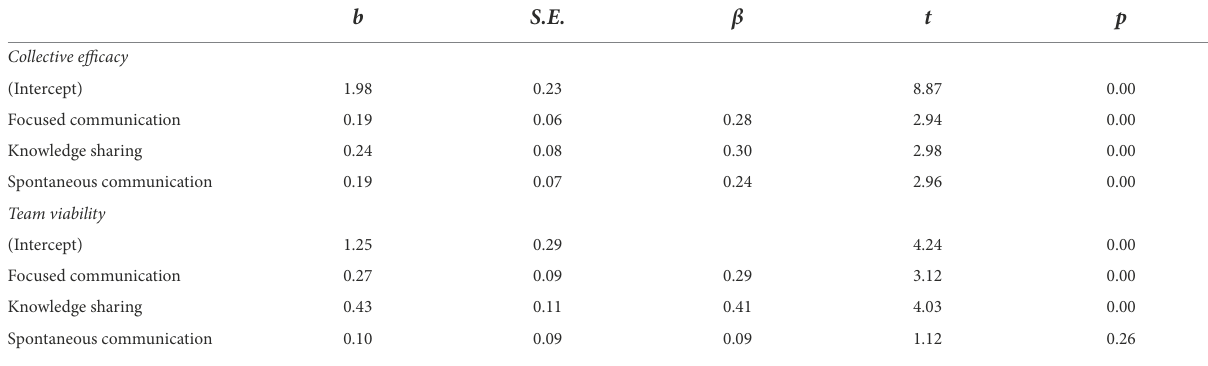
TABLE 7 Coefficients of multiple linear regression of TCS on team collective efficacy.